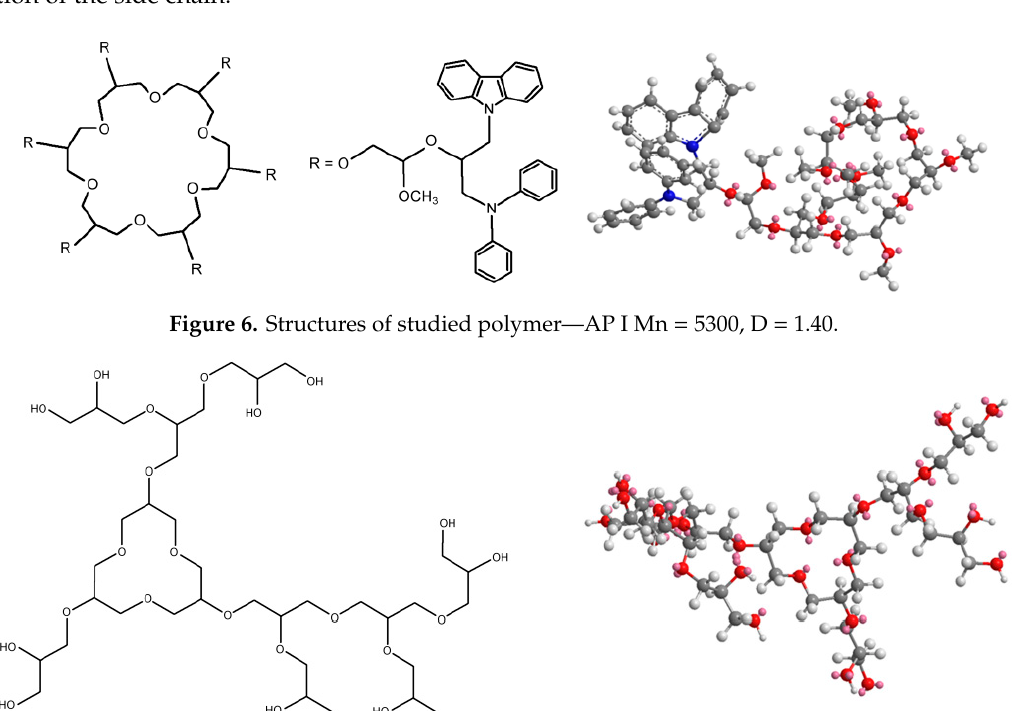
Figure 8. Structures of studied polymer—S XVII Mn = 6450, D = 1.45.